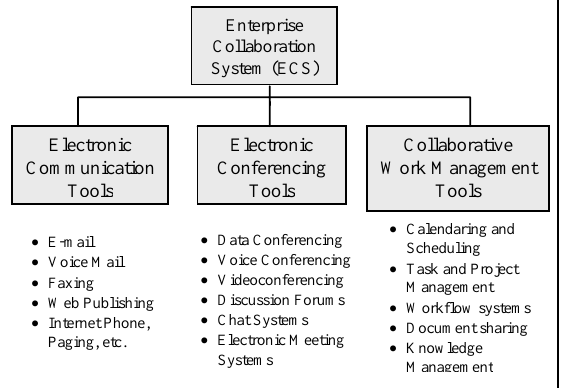
Figure 1 - Enterprise Collaboration System [7] Figure 2 - Mobile and Fixed Subscriptions worldwide